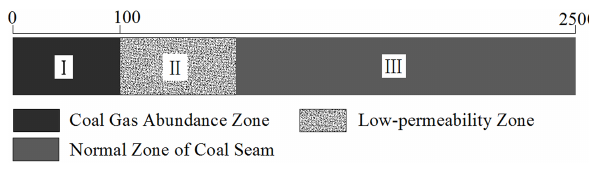
Figure 4. One-dimensional flow model of coal gas with a low- permeability zone. Table 2. Parameters of the flow